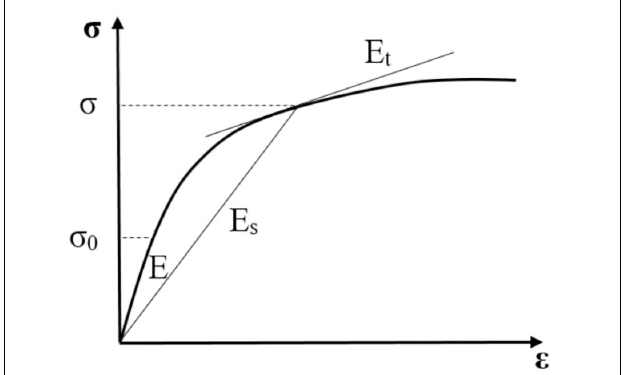
FIGURE 1 | Elastic E , tangent E t and secant E s moduli in a simple tensile test. σ o is the linear elastic limit